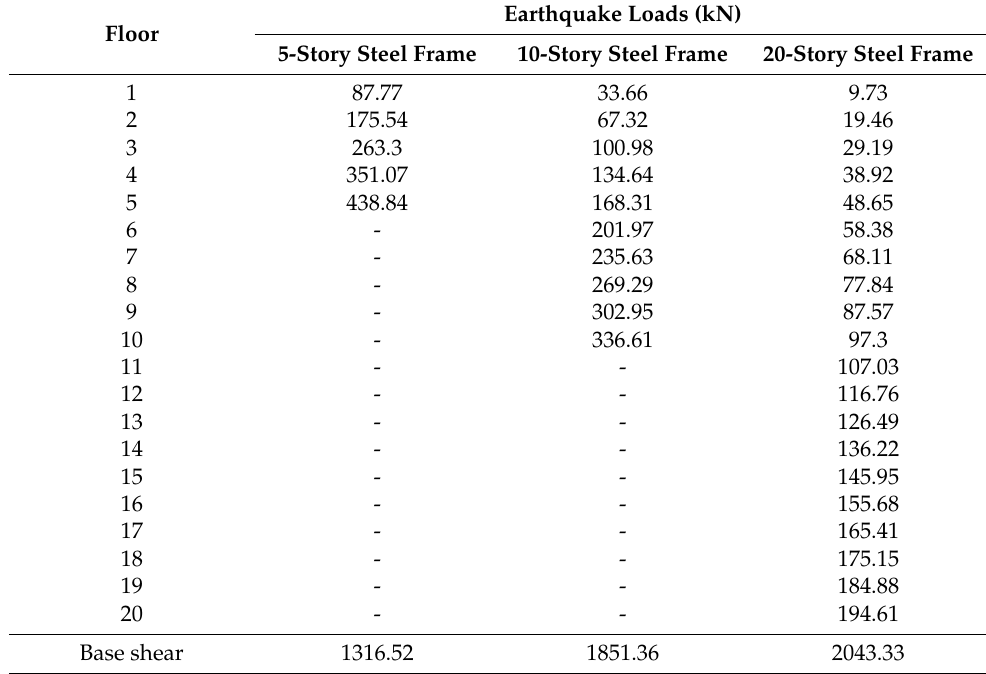
Table 3. Earthquake load acting on 5-, 10-, and 20-story steel